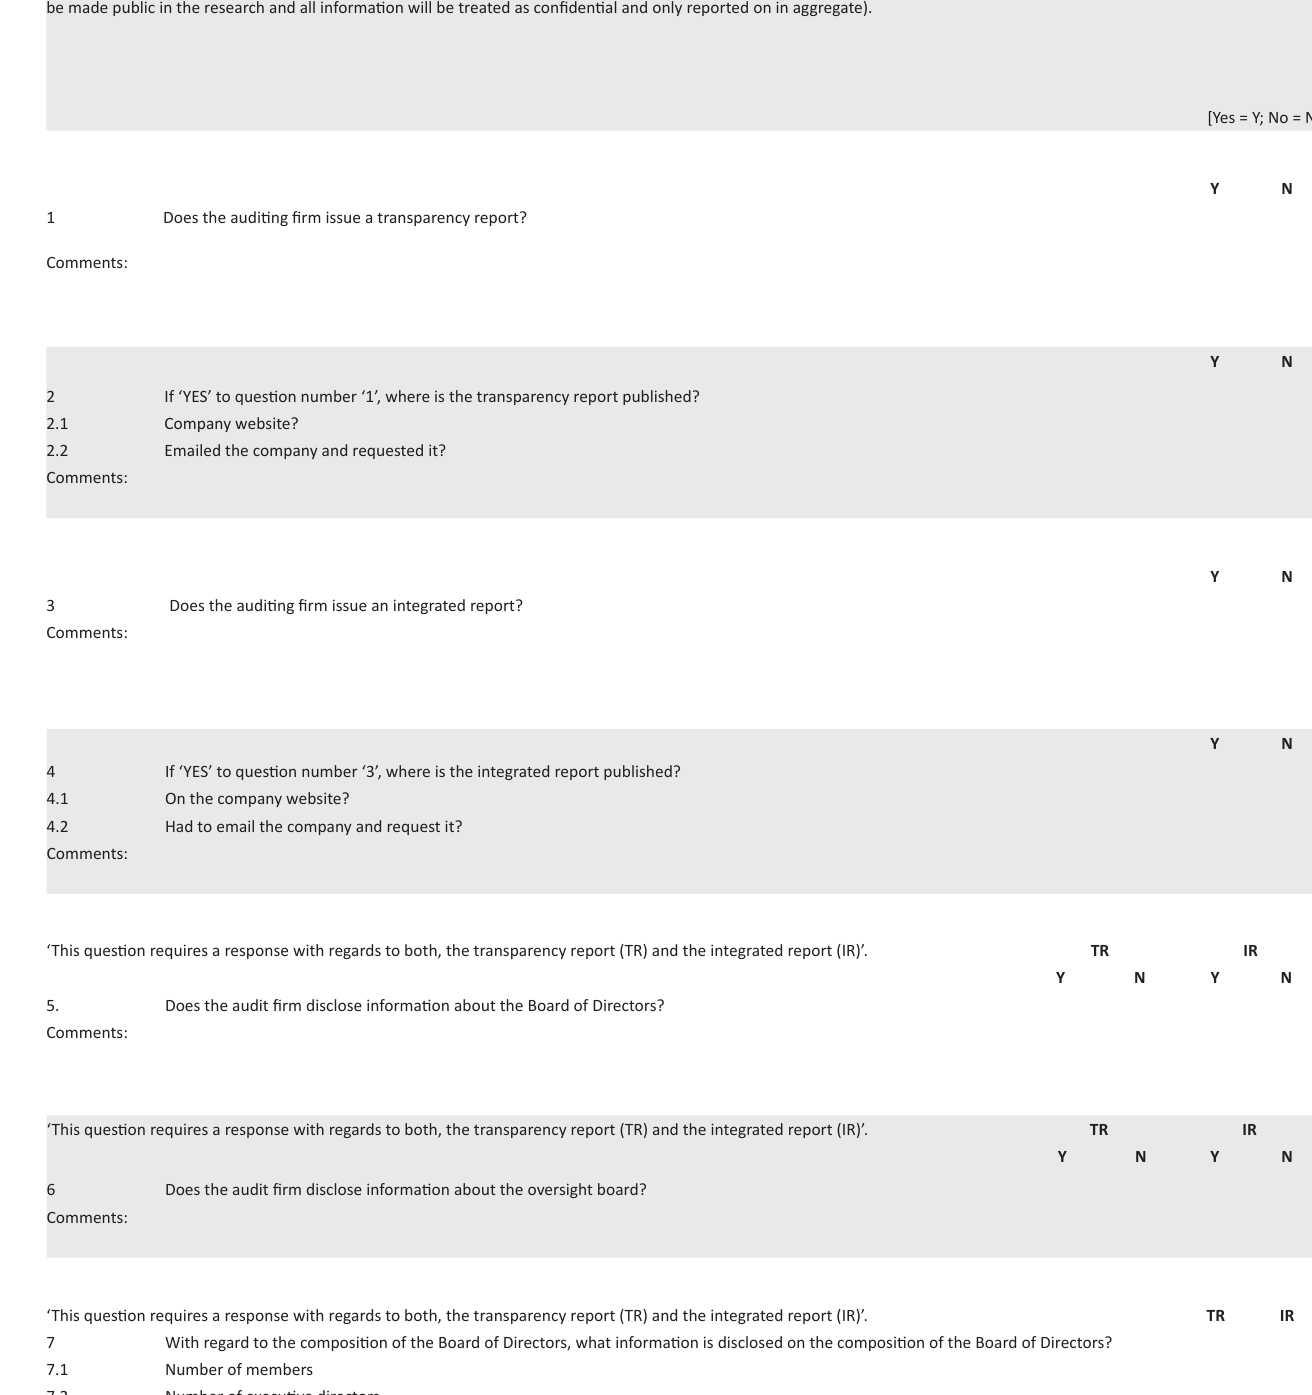
TABLE 1-A1: Checklist used for the empirical study. Control sheet for the analysis of the transparency reports Name of the company or firm: (This will only be used should additional information be required after the completion of the questionnaire. The names of the auditing firm will not be made public in the research and all information will be treated as confidential and only reported on in